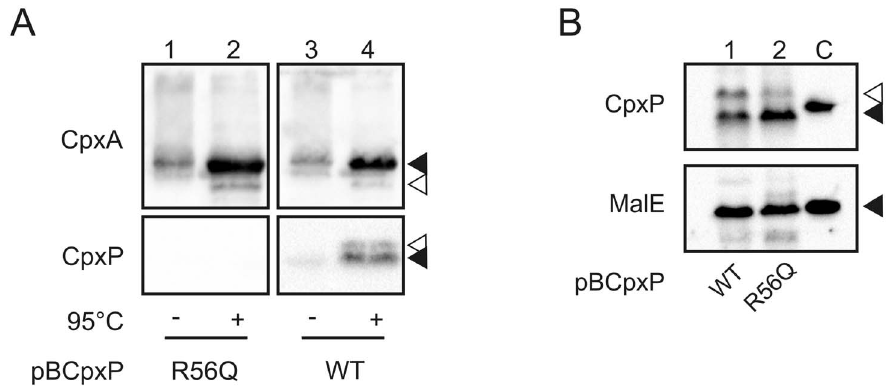
Figure 3. Variant CpxPR56Q is not co-purified with CpxA. A) Substitution of amino acid residue R56 to Q of CpxP results in a stable protein that does not inhibit the Cpx-pathway [27]. mSPINE experiments were performed as described in Fig. 2A with E. coli TG1 producing CpxA-Strep (pKT01E) and CpxPR56Q (pBcpxPR56Q/R56Q) or CpxP (pBcpxP/WT) grown in LB supplemented with 0.002% arabinose. Black triangles show specific and the white triangle unspecific reactions. Shown are representatives of two biological replicates. B) To verify similar CpxP protein level in each mSPINE experiment, whole cells from (A) were collected after formaldehyde treatment, and subjected to immunological determination using antiserum to the CpxP protein, and the MalE protein (loading control), respectively. Purified His6-CpxP and MalE served as controls for antibody specificity (C). Black triangles show specific and white triangles unspecific reactions.